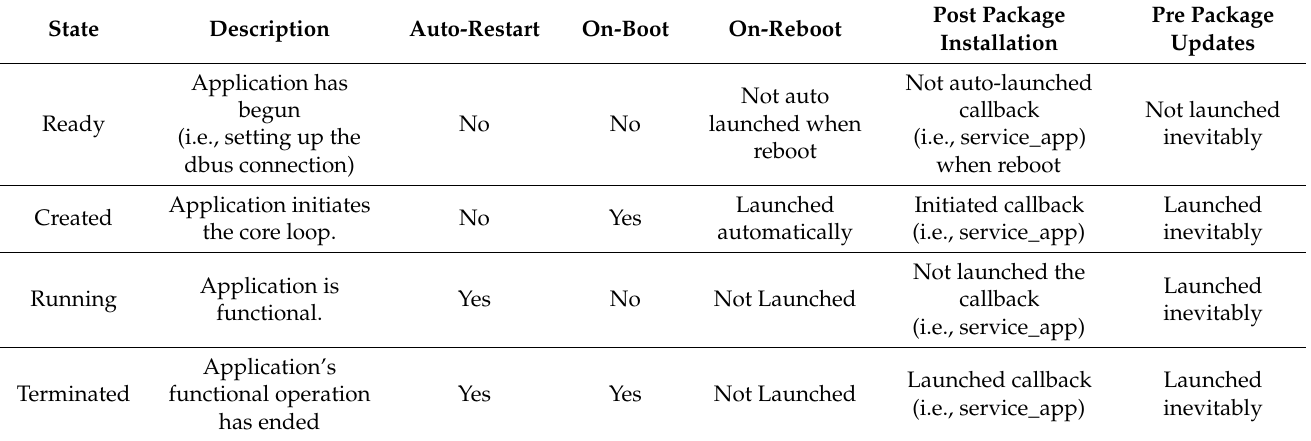
Table 2. System Service